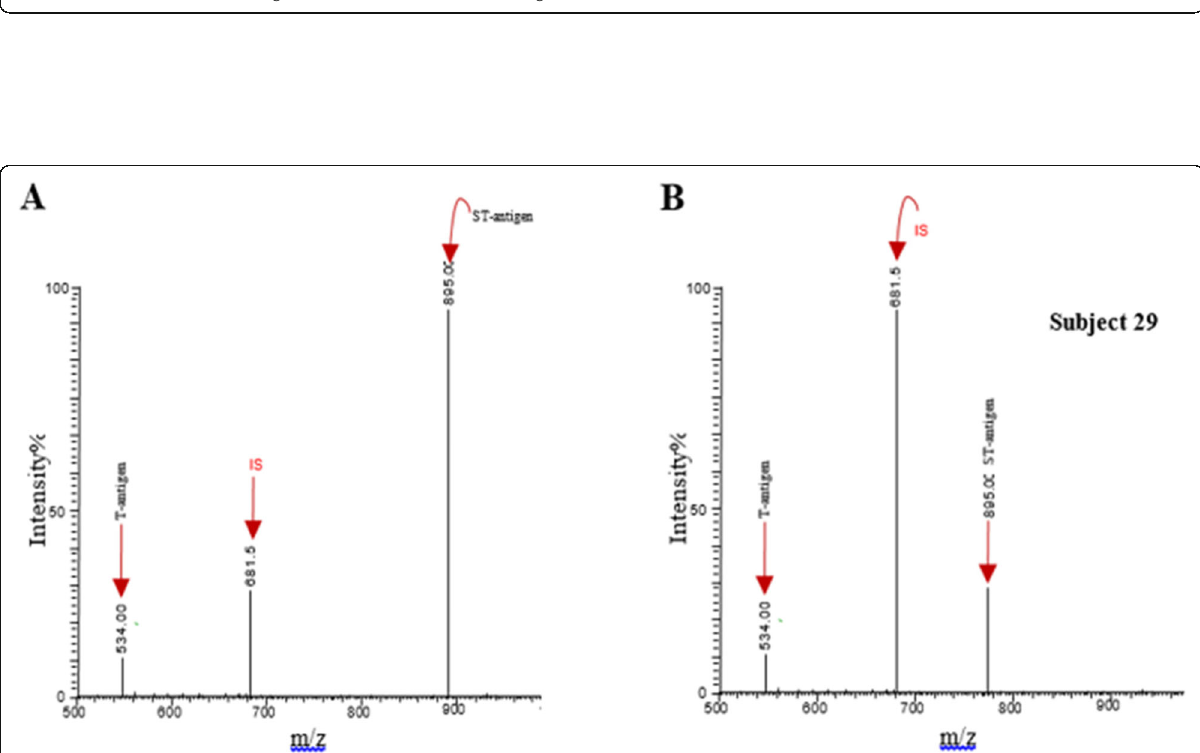
Fig. 4 Analysis of T-antigen and ST-antigen by LC-MS/MS with a calibration curve of T-antigen standard, b calibration curve of ST-antigen standard, c mean ± SD of T-antigen and d mean ± SD of ST-antigen